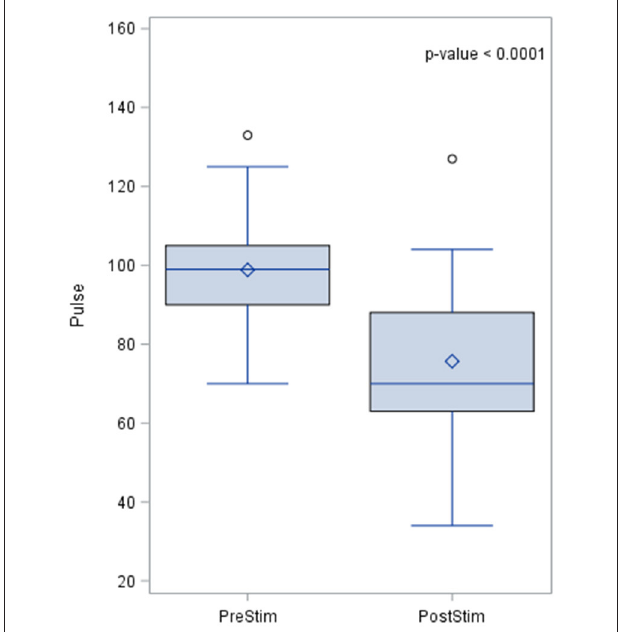
FIGURE 5 | Effects of baroreceptor stimulation on pulse rate. The results of the distribution of the median are shown in the figure, together with the p -value after applying the Wilcoxin rank test. Pulse rate values are presented in beats per minute.